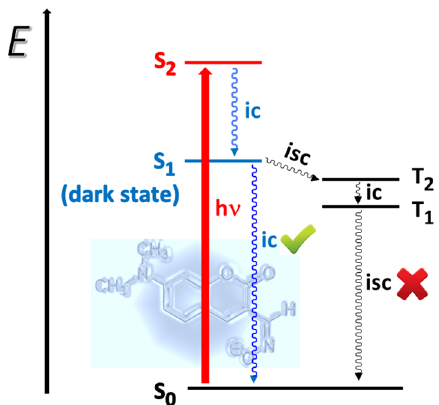
Figure 4. Fluorescence quenching mechanism of 7-dimethylaminocoumarin oxime 1 in the presence of strongly basic F − anions (state diagram and de-excitation pathways for 7-dimethylaminocoumarin oximate anion).